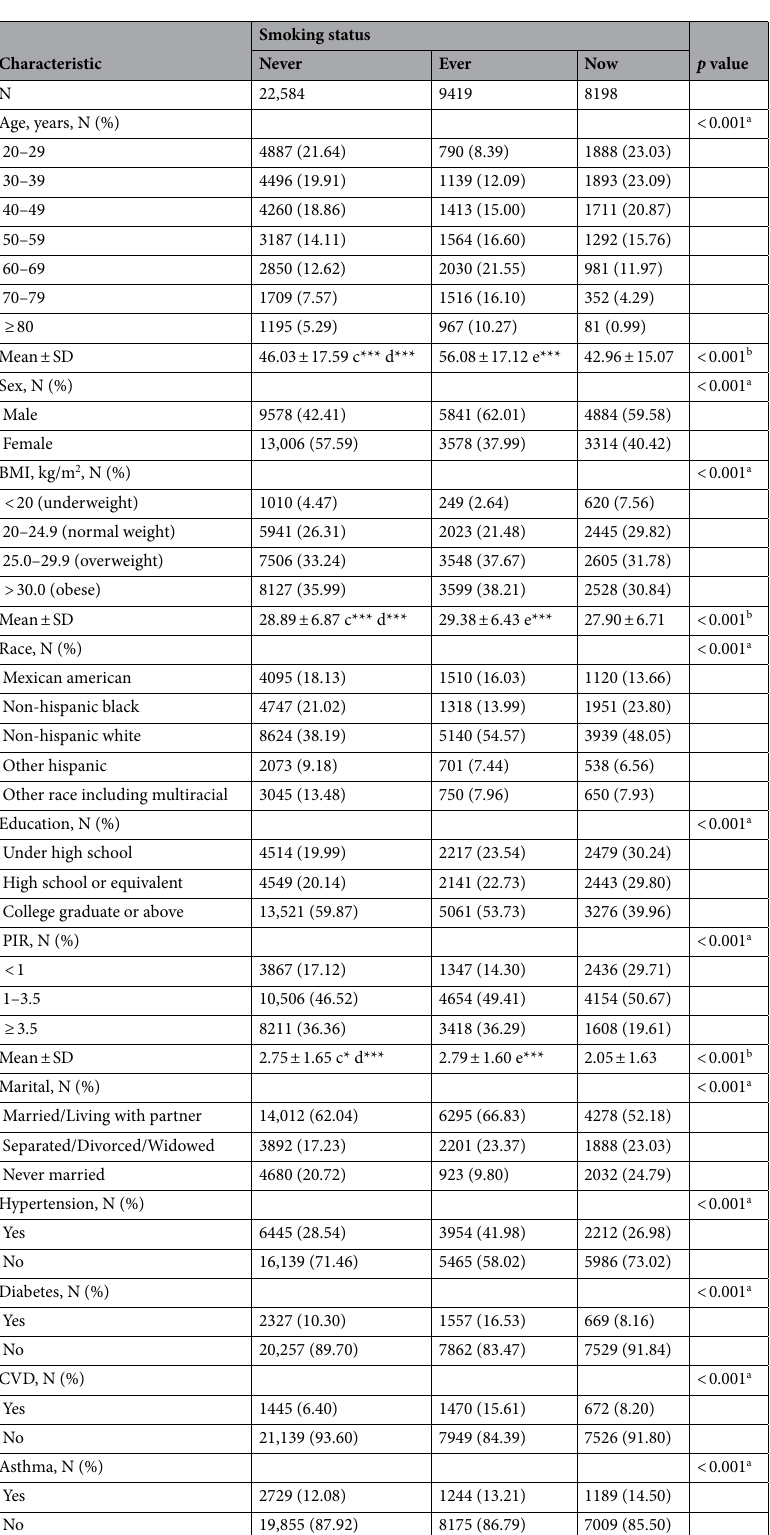
Table 2. Characteristics of participants based on smoking status. a means Chi-square test, b means one-way ANOVA test, c,d,e post-hoc comparisons using LSD between Never and Ever, Never and Now, and Ever and Now, respectively. * p < 0.05, ** p < 0.01 *** p <